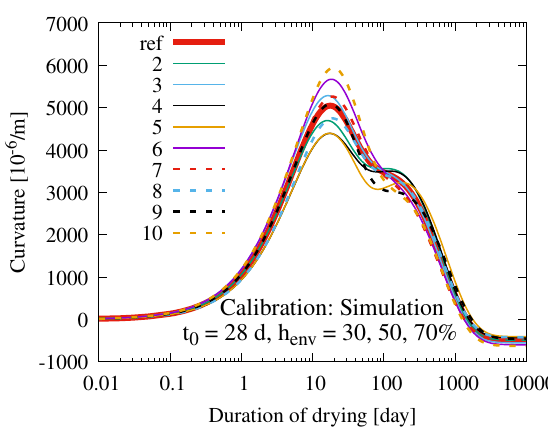
Figure 8. Prediction of curvature of 75 mm thick slab exposed to drying from one side only at h env = 50% which started at t 0 = 28 days. The line types and the material parameters correspond to identification at 3 di ff erent levels of h env (Figs. 6 and 7).